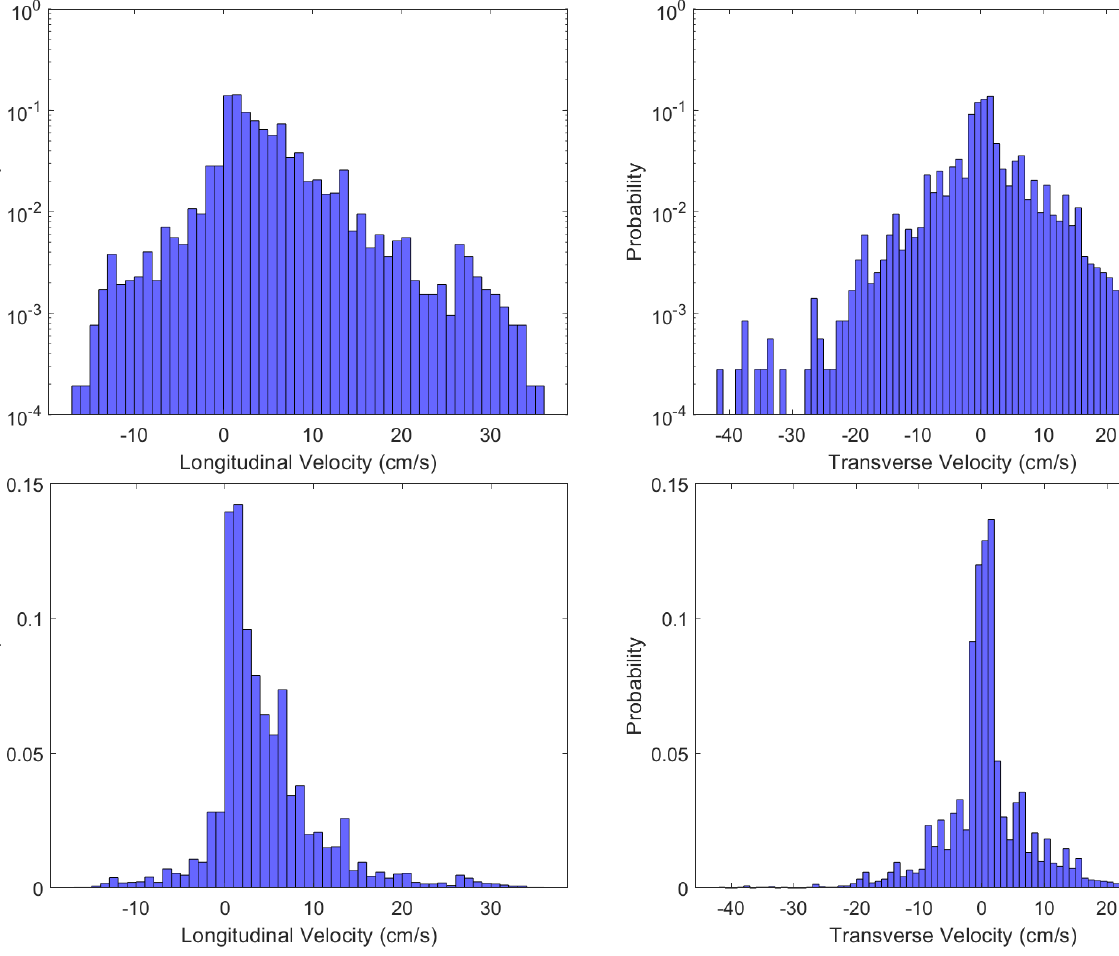
Figure 13. ( Left ): Longitudinal velocity distribution with mean µ L = 4.60 cm/s, standard deviation σ L = 6.22 cm/s, and kurtosis κ L = 6.82. ( Right ): Transverse velocity distribution with mean µ T = 0.74 cm/s, standard deviation σ T = 7.43 cm/s, and kurtosis κ T = 6.60. The top plots are in logarithmic scale and the bottom plots are in linear